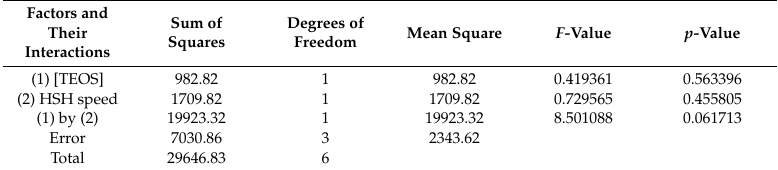
Table 4. Evaluation of the factors TEOS concentrations ([TEOS]) and HSH speed as well as their interactions. Analysis of the particle size using ANOVA statistical test.